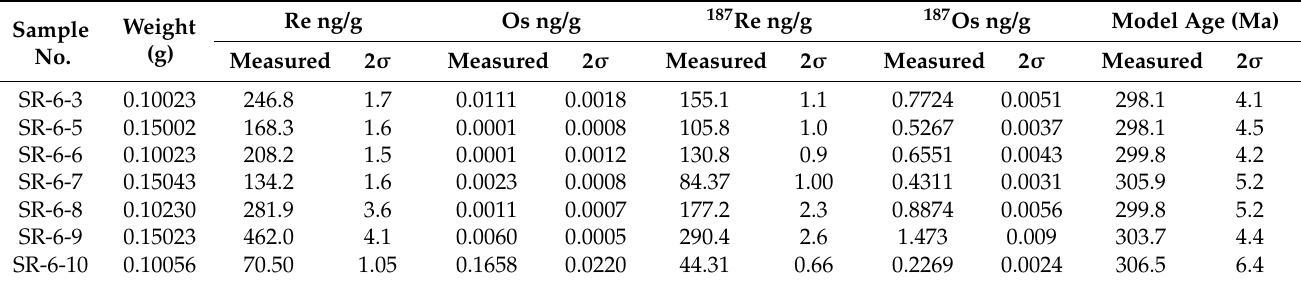
Table 4. Re–Os isotopic data for molybdenite from the Sayashk Sn